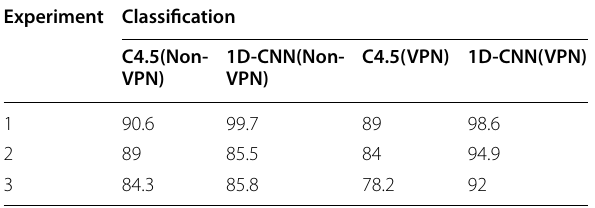
Table 5 Comparison of precision of encrypted and non- encrypted traffic identification for C4.5 and 1D-CNN Experiment Classification